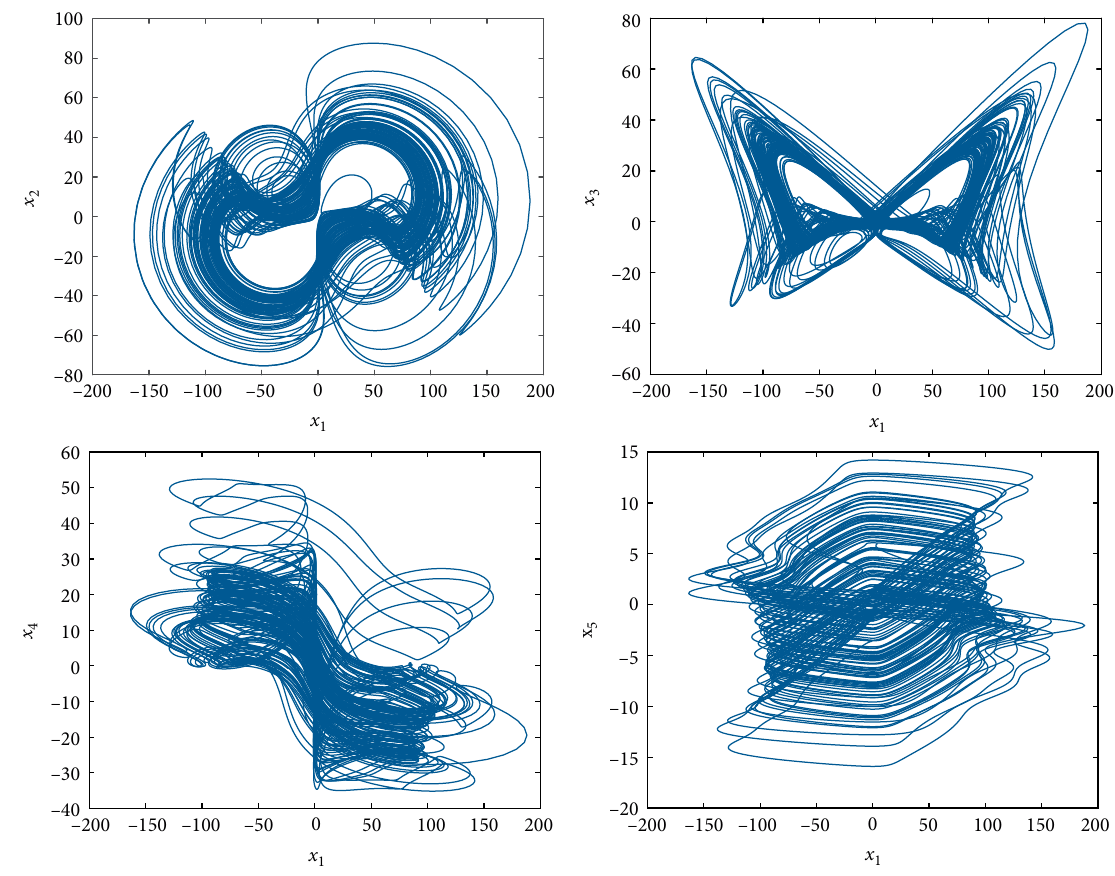
Figure 4: 2D projections of the hyperchaotic